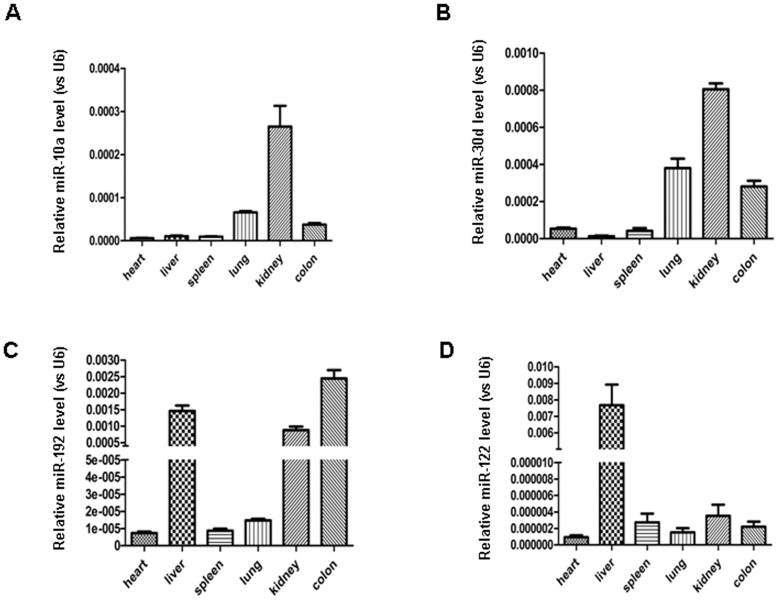
Identification of miR-10a and miR-30d as mouse kidney-enriched miRNAs.RNA from various organs of normal C57BL6 mice was extracted, and the miRNA levels were determined by qRT-PCR assay using U6 as an internal control.